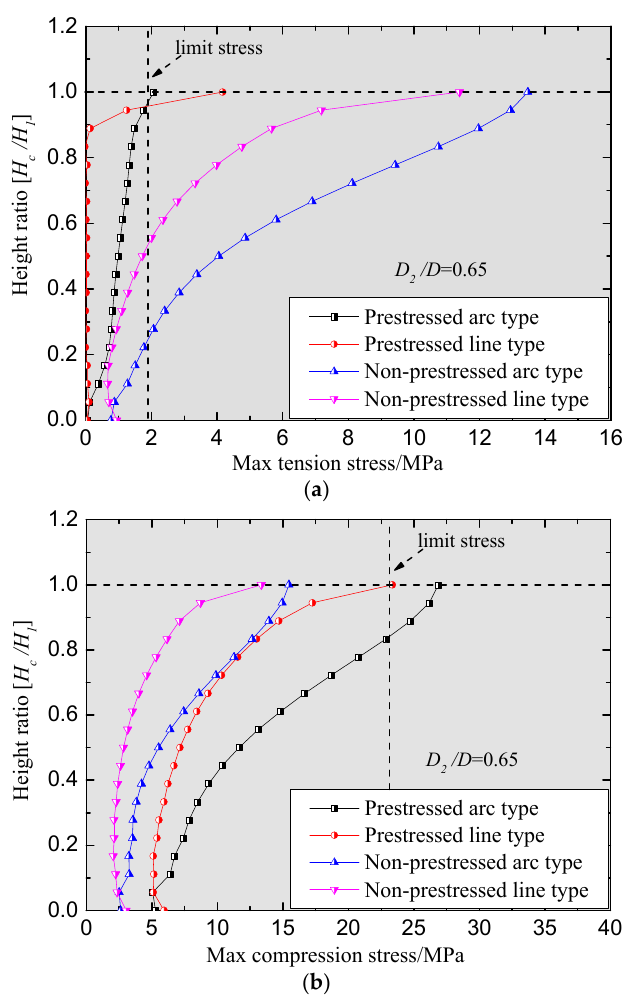
Figure 5. The cross-section stress ultimate load condition: ( a ) Maximum stress of the tension side; ( b ) Minimum stress of the compression side.